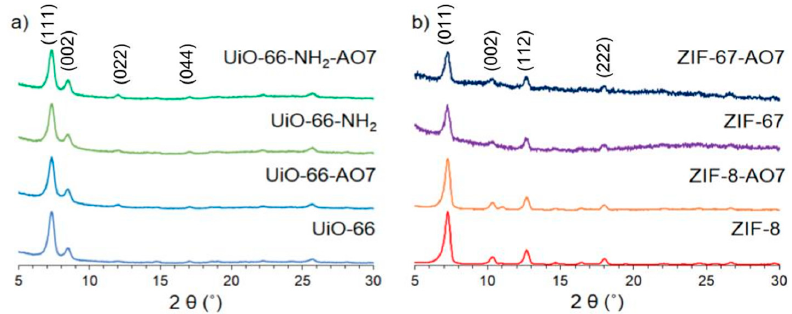
Figure 1. PXRD patterns of ( a ) UiO-66 (blue) and UiO-66-NH 2 (green) and ( b ) ZIF-8 (red) and ZIF-67 (purple) prior to and following decontamination experiments.